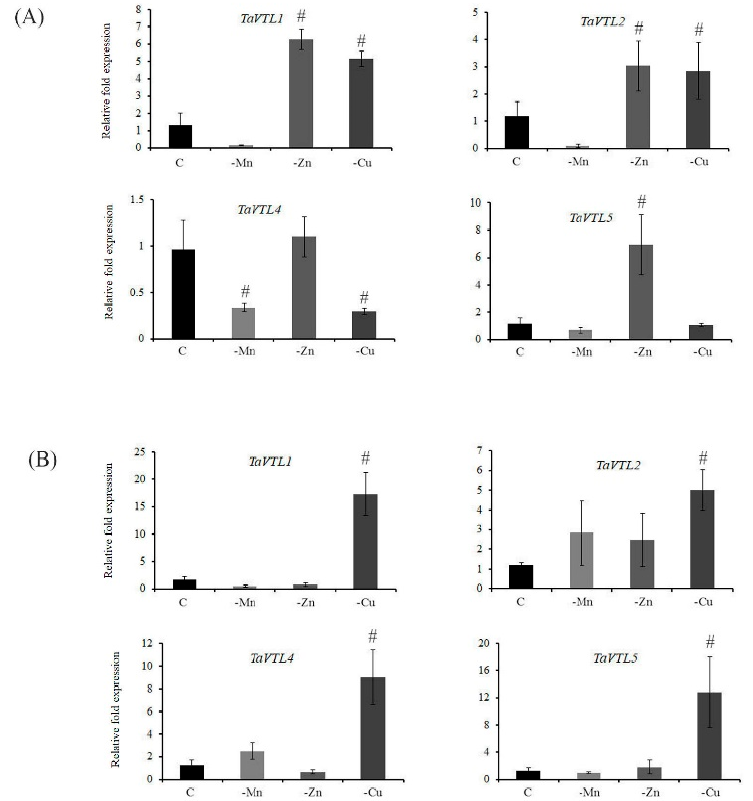
Figure 6. Tissue-specific qRT-PCR expression analysis of wheat VTL genes during Mn (-Mn), Zn (-Zn) and Cu (-Cu) deficiency with respect to the control (C) conditions. ( A ) Fold expression analysis was performed in roots and ( B ) in shoots. 2 µ g of total RNA was used for the cDNA preparation and relative fold expression levels were calculated relative to control tissue (C). The C t values were normalized using wheat ARF1 as an internal control. Vertical bars represent the standard deviation. # represents the significant di ff erence at p < 0.05 with respect to Control